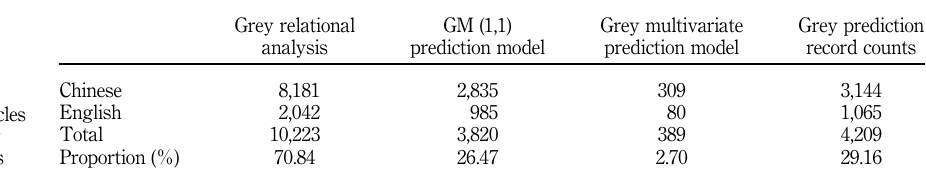
Table I. Language of articles in GRA and grey prediction models